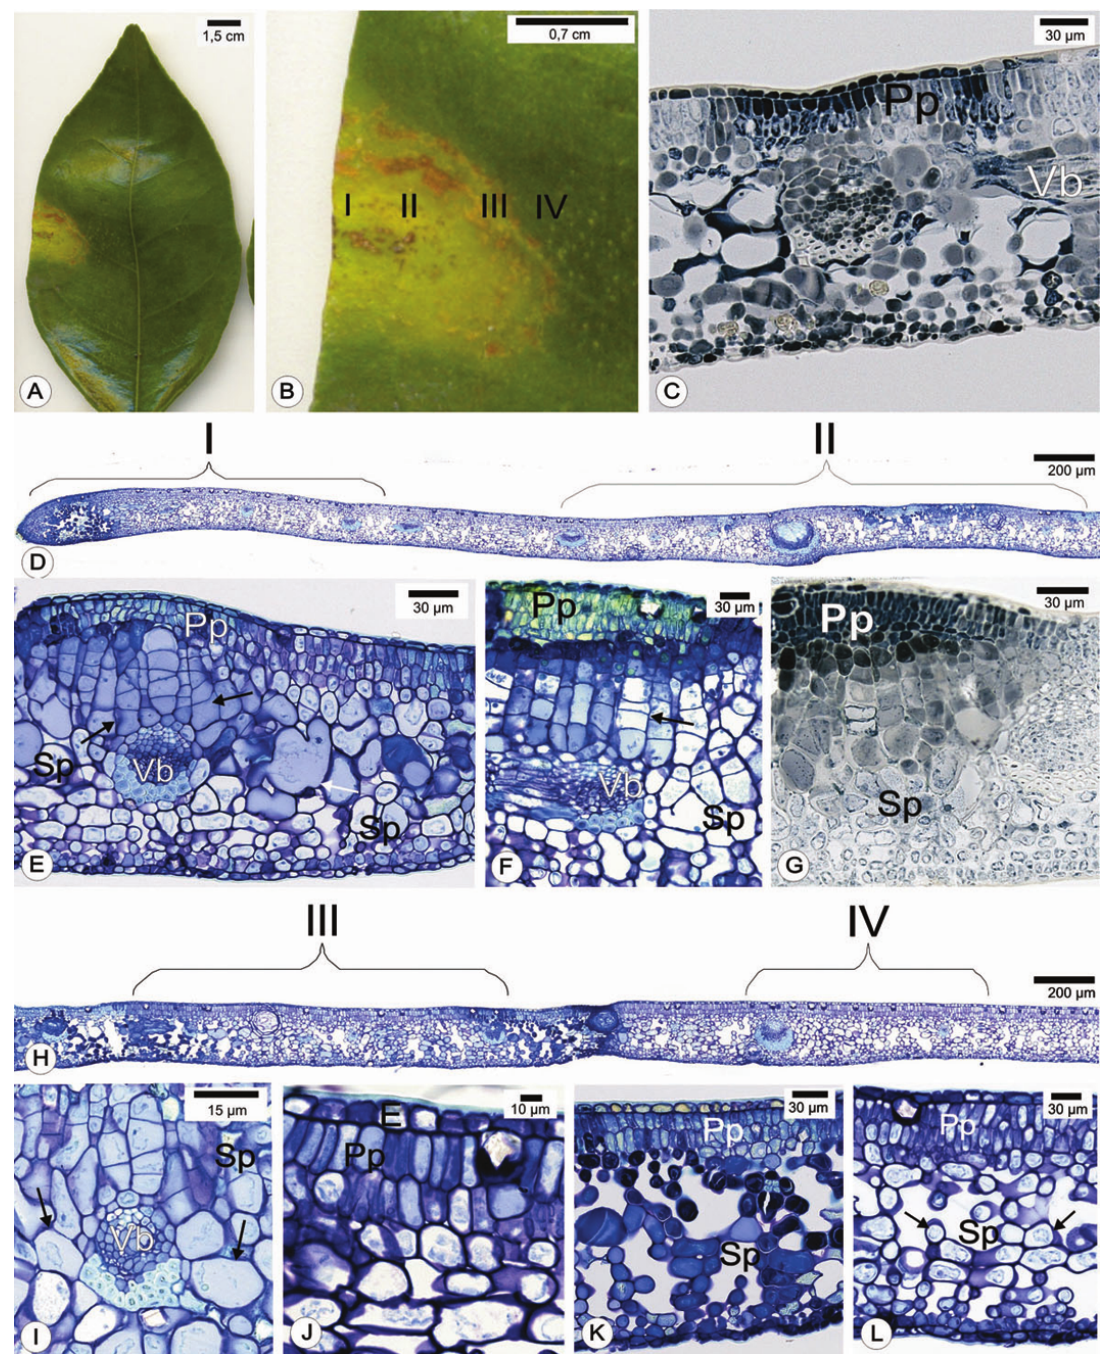
Fig. 2 – Cross sections (A-E, H-M) and morphology (F-G) of the leaf lesions caused by CiLV-C in Citrus sinensis (L.) Osbeck ‘Pêra’. Figure C corresponds to sector I indicated in B and D. Figures E-G and I-J correspond to sectors II, and K-L correspond to sectors III and IV, respectively. Figures D and H are cross sections of the lesion shown in B with the corresponding sectors I to IV. C and G. Lipid content (blackish region). E-F. Hyperplasia (black arrows) and hypertrophy (white arrow in E) of spongy parenchyma cells. In I there is the hypertrophy of bundle sheat cells (arrows). K. Necrosed cells. L. Plasmolysed cells (arrows) E – Epiderm; Vb – Vascular bundle; Sp – Spongy parenchyma; Pp – Palisade